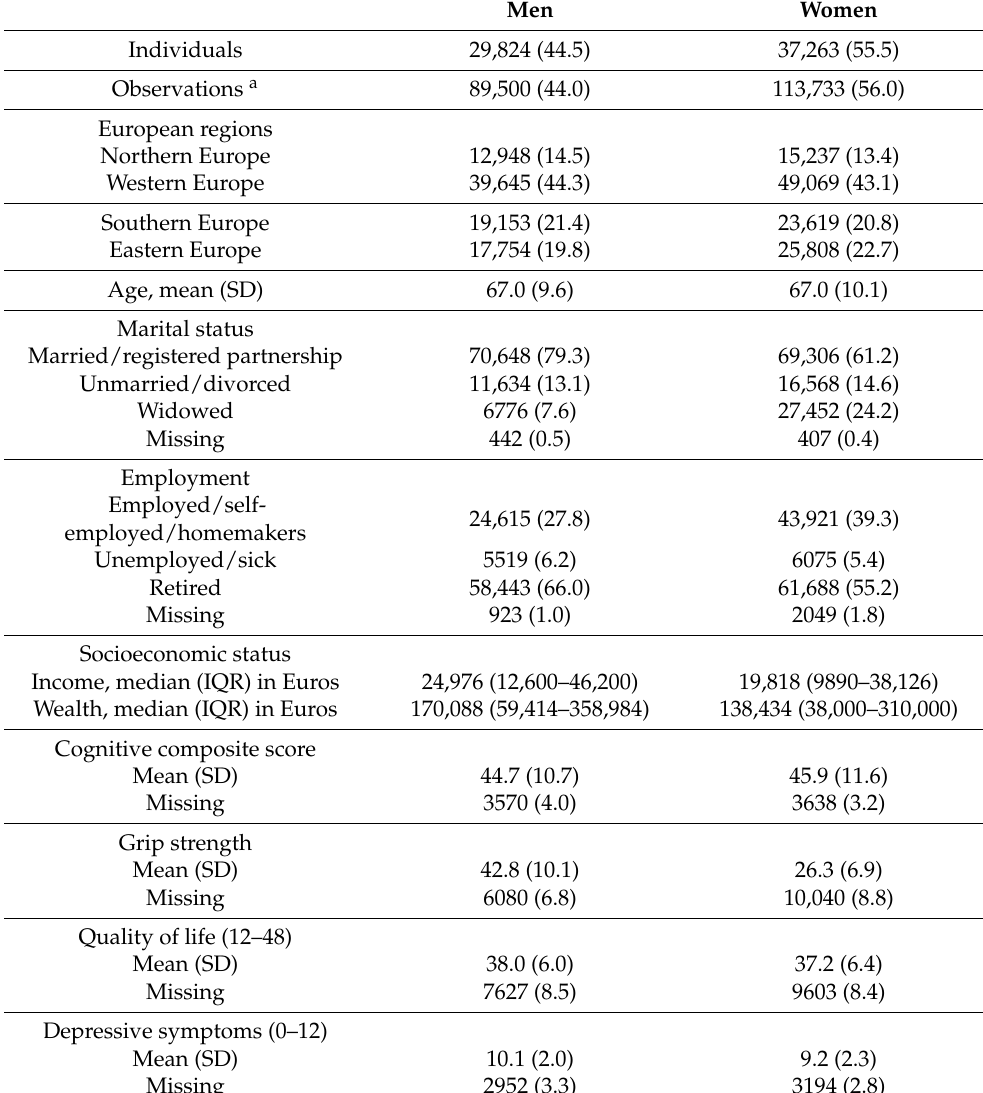
Table 1. Baseline characteristics of 67,087 European men and women (corresponding to 203,233 observations) participating in at least two consecutive waves of the Survey of Health, Ageing and Retirement in Europe